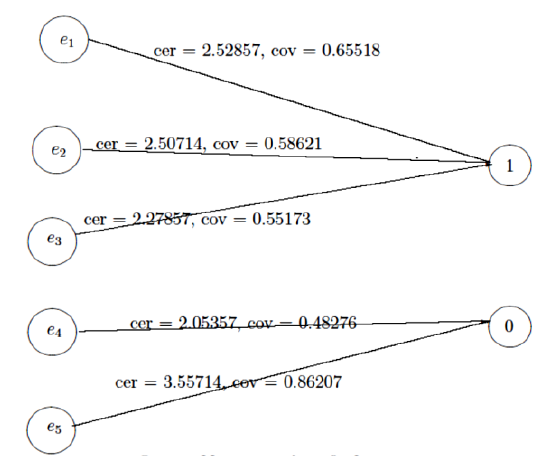
Fig. 4. Approximate flow